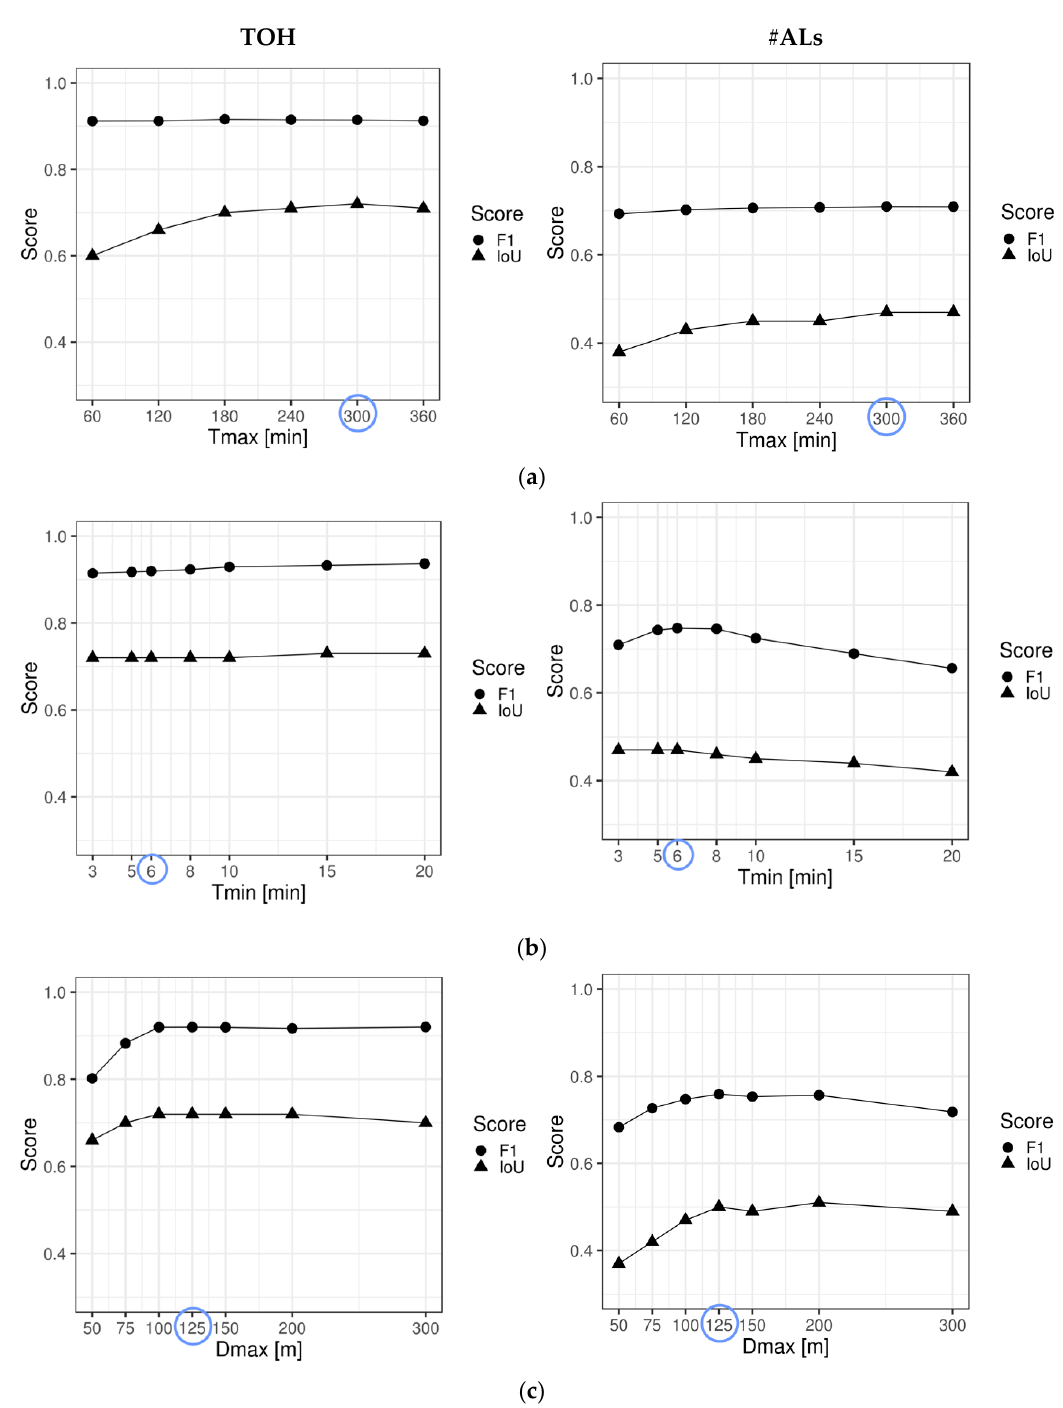
Figure 8. Results of stepwise sensitivity analysis of Tmax , Tmin , and Dmax. ( a ) Optimization of Tmax for initial settings ( Tmin = 3 min, Dmax = 100 m). ( b ) Optimization of Tmin for initial Dmax = 100 m and optimized Tmax = 300 min, ( c ) Optimization of Dmax for optimized Tmin = 6 min and Tmax = 300 min.